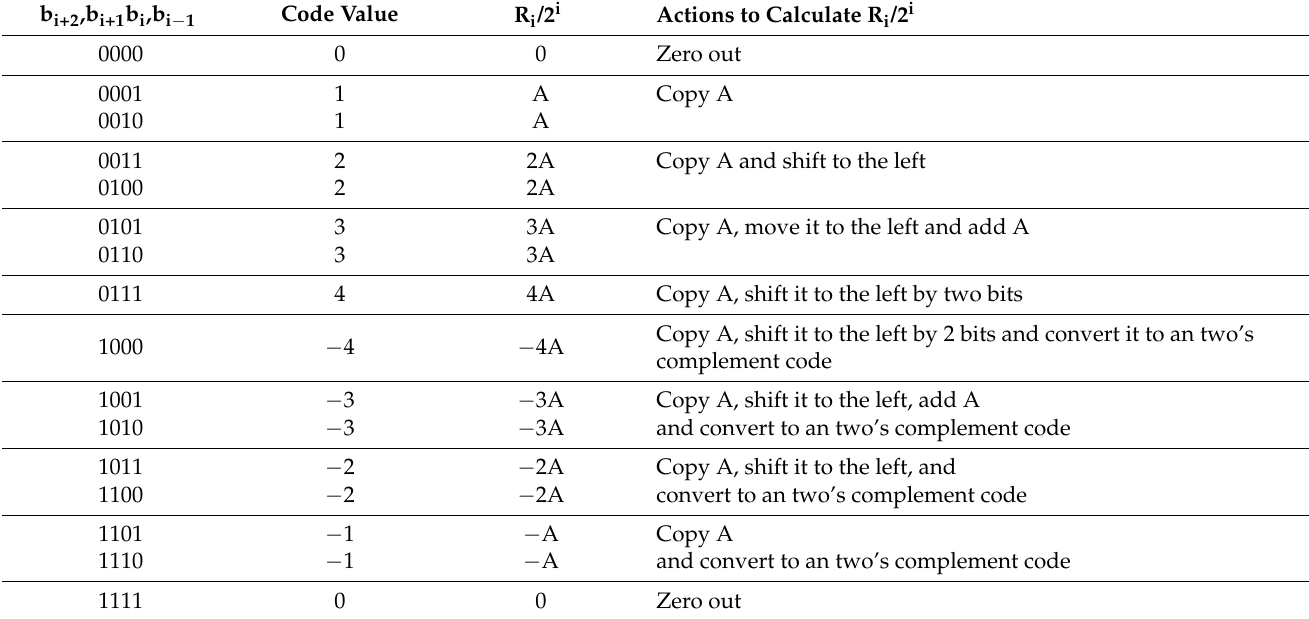
Table 2. Table of operations to form partial products for multiplication by three digits.